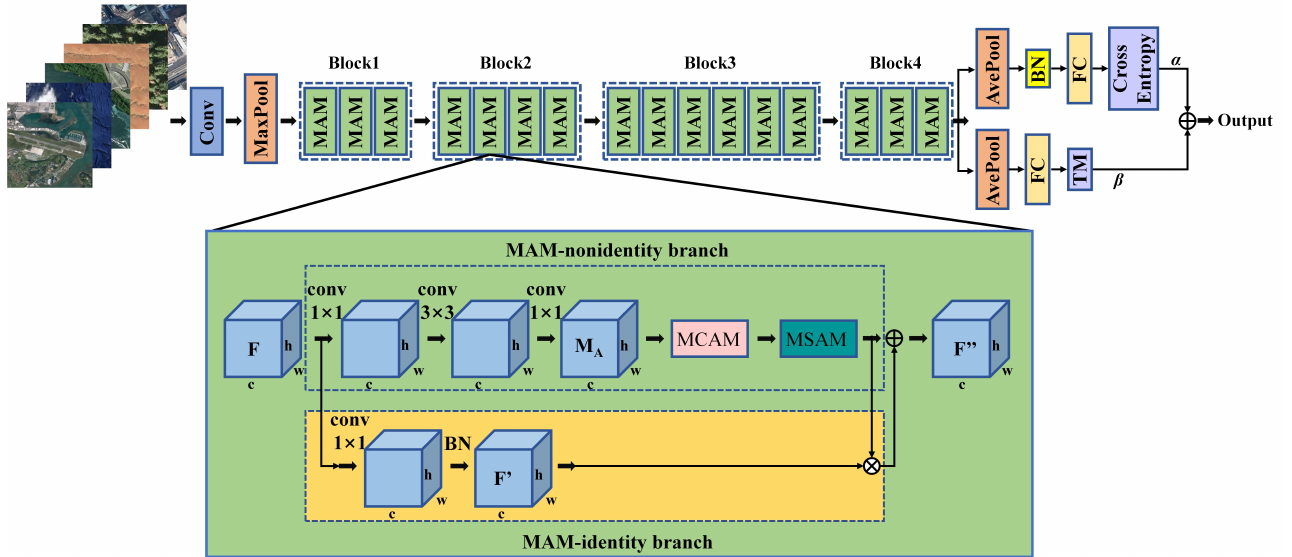
Figure 2. The overall structure of the proposed TMGMA. (cid:76) and (cid:78) represent element-wise summa- tion and multiplication,